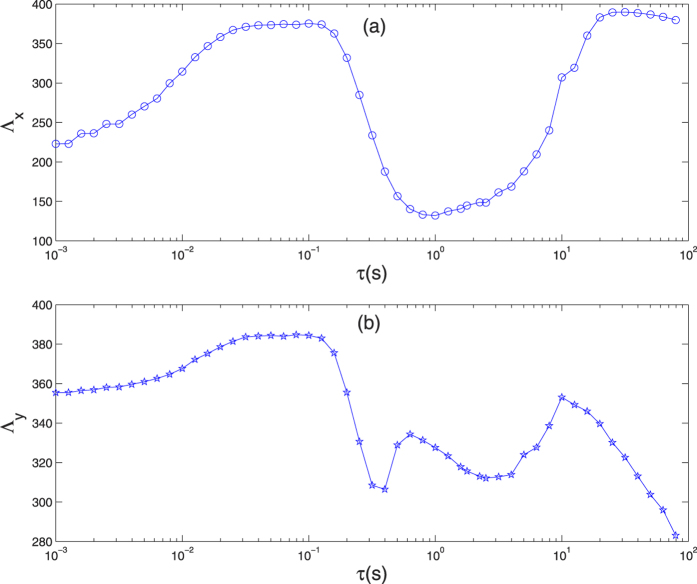
CCT Λx and Λy vs. time delay are simulated.